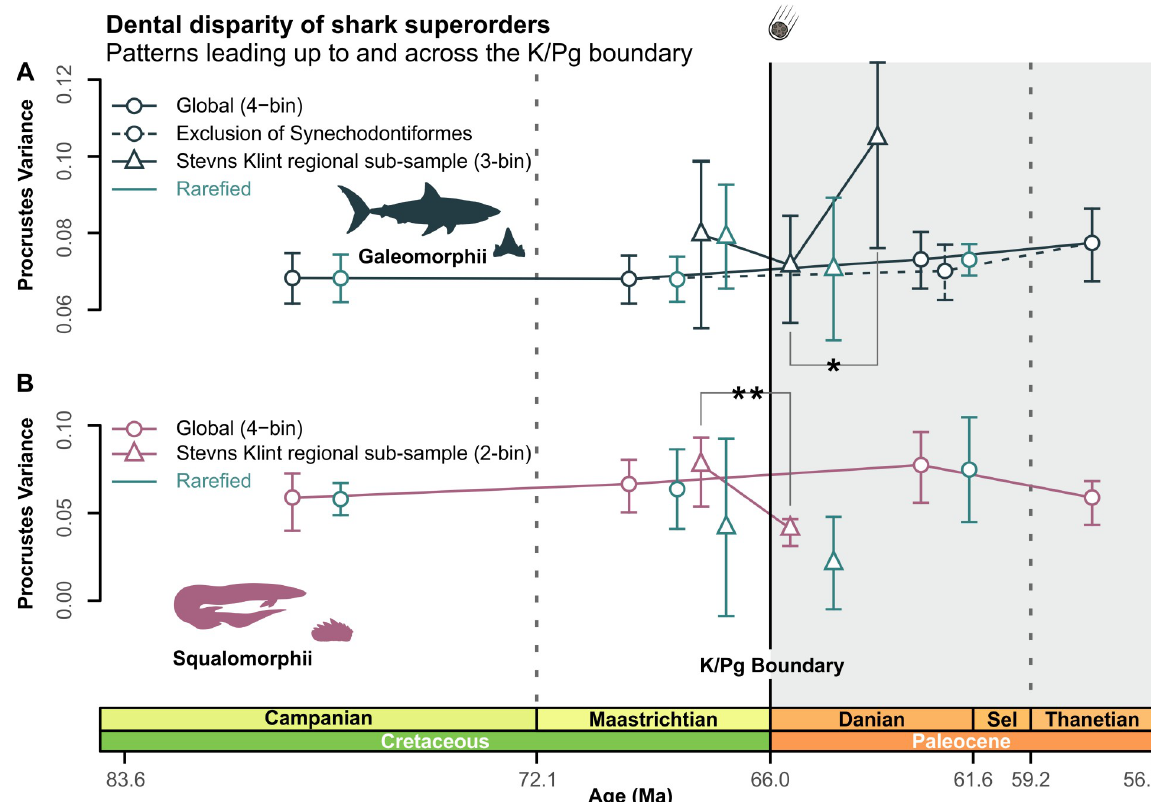
Fig 3. Superorder-level clade disparity profiles. (A, B) Global/regional raw and rarefied dental disparity trajectories for Galeomorphii (including and excluding †Synechodontiformes) and Squalomorphii. Sample rarefaction: Galeomorphii, N = 169; Squalimorphii, N = 18. Significant FDR-adjusted p -values for multiple comparisons are indicated ( � p < 0.05, �� p < 0.005). Silhouette graphics created by MB. The data used in this analysis can be accessed online at https://doi.org/10.5061/dryad.c866t1g5n. FDR, false discovery rate; K/Pg, Cretaceous/Paleogene; Ma, million years; Sel,